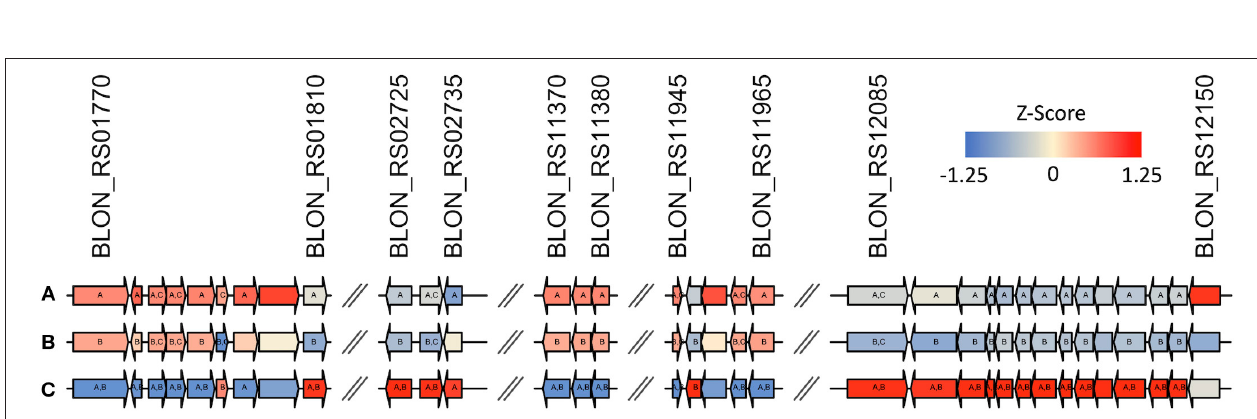
FIGURE 6 | Gene maps show that there is differential regulation across the entire fucose metabolic pathway during growth on (A) 0.8% 2 ′ fucosyllactose, (B) 2% 2 ′ fucosyllactose, and (C) lactose as described by z-scores calculated from normalized count data. Gene annotations and predicted functions are provided in Supplementary Table 2